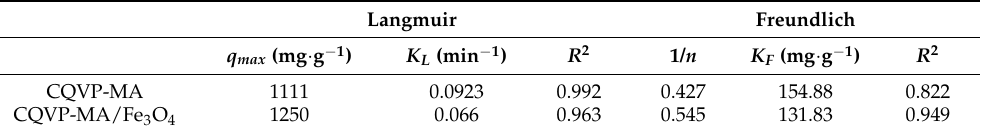
Table 4. Langmuir and Freundlich isotherms for the adsorption of CBB dye onto CQVP/MA and CQVP/MA-Fe 3 O 4